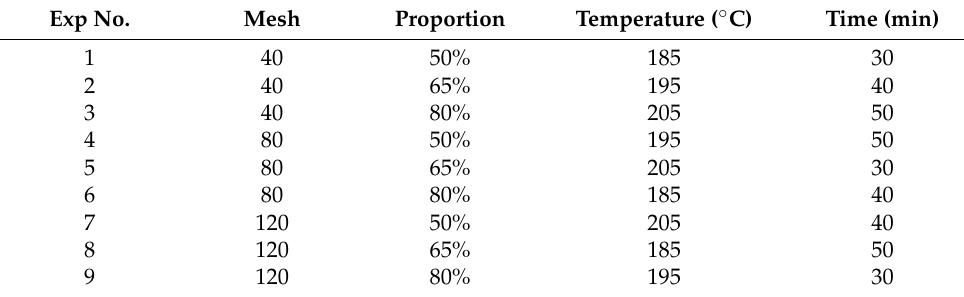
Table 3. DOE for final experimentation.